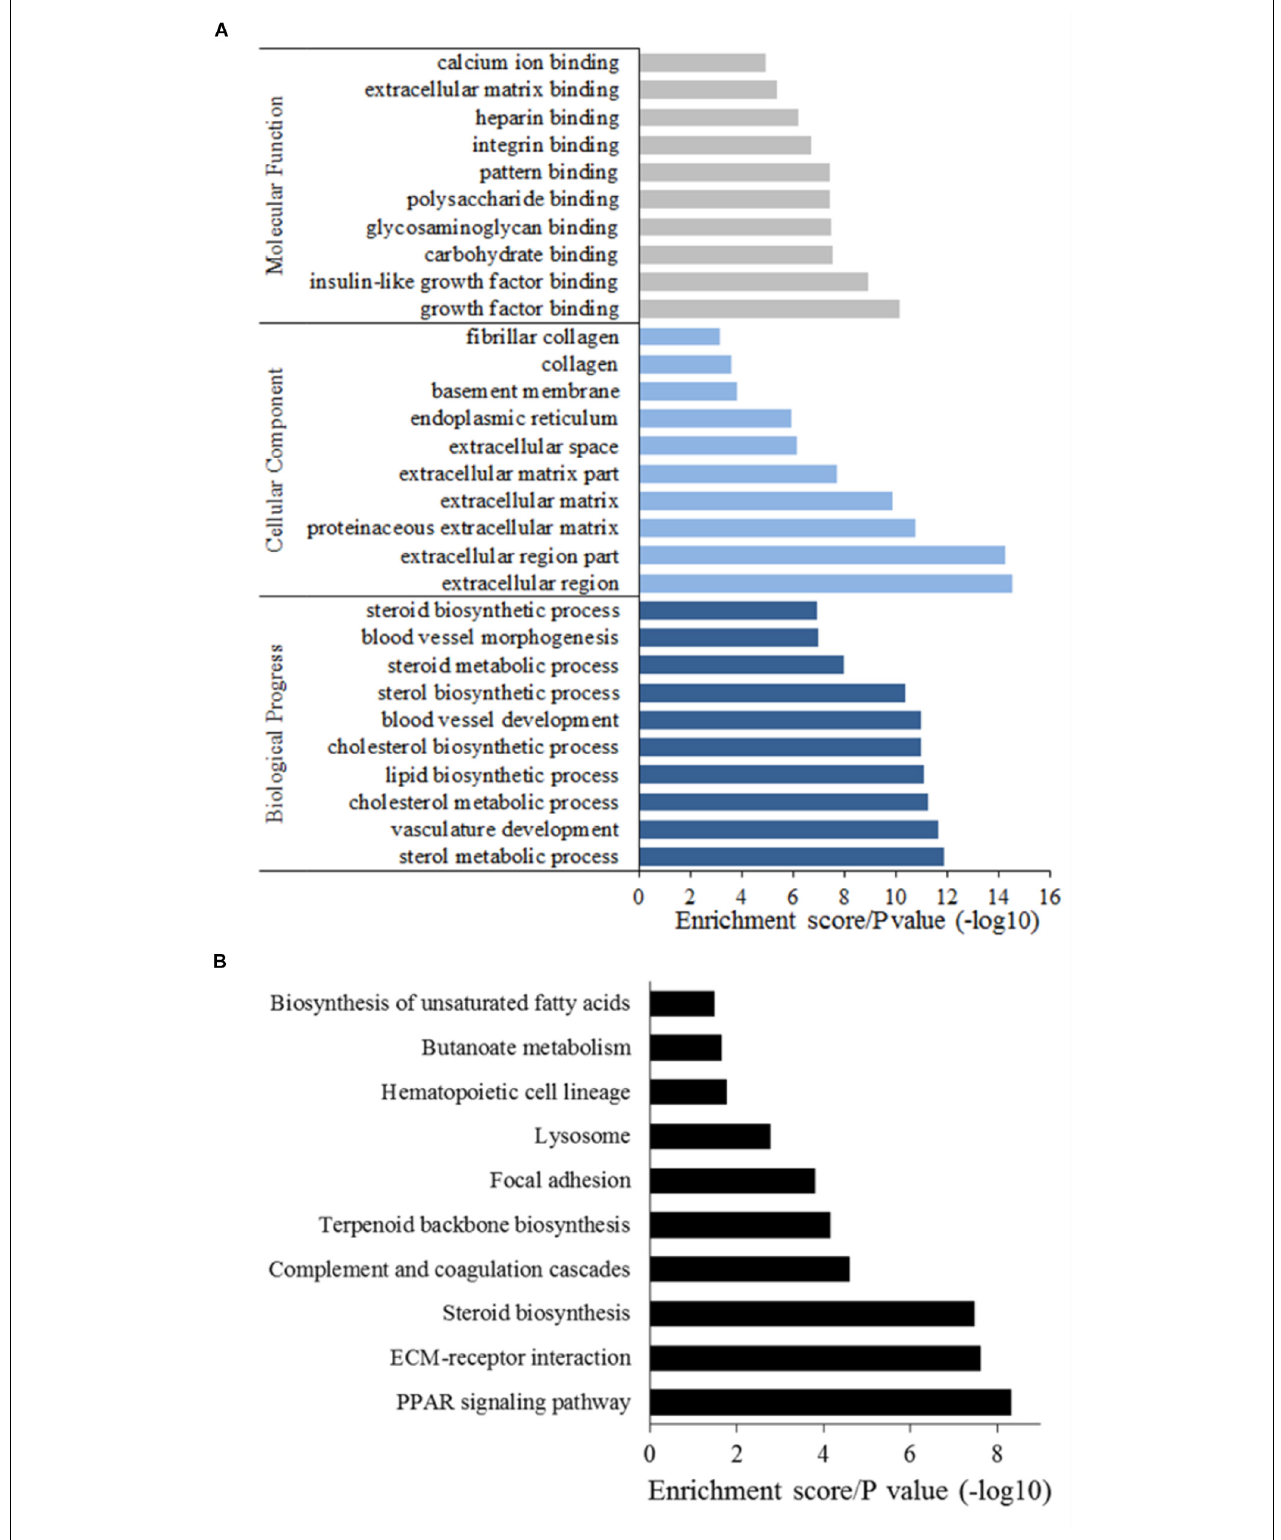
FIGURE 4 | GO annotation (A) and KEGG analysis (B) of